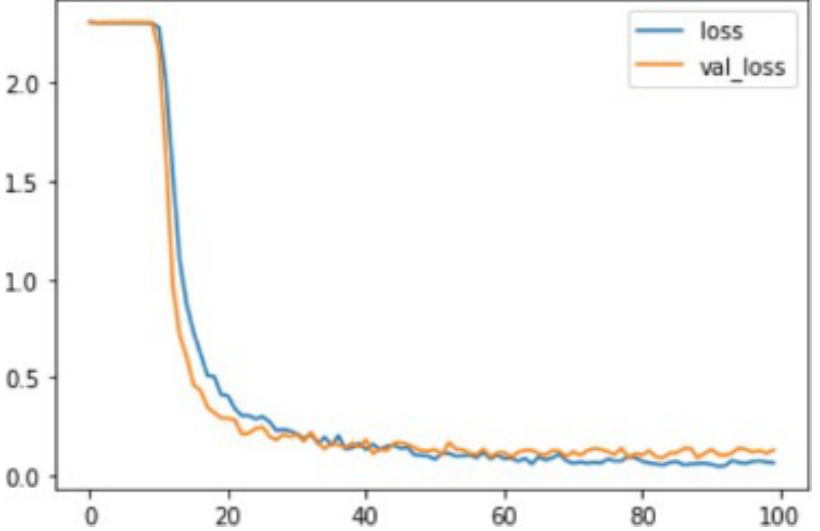
Figure 14. Graph of loss against the number of epochs in training and testing of the CNN